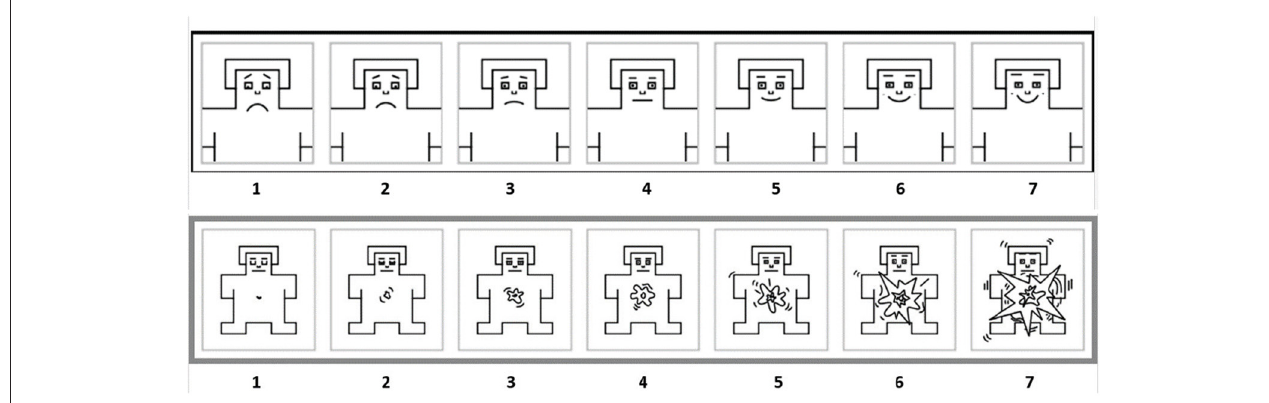
FIGURE 6 | Schematic diagram of affective rating. The top is valence rating. The bottom is arousal rating.